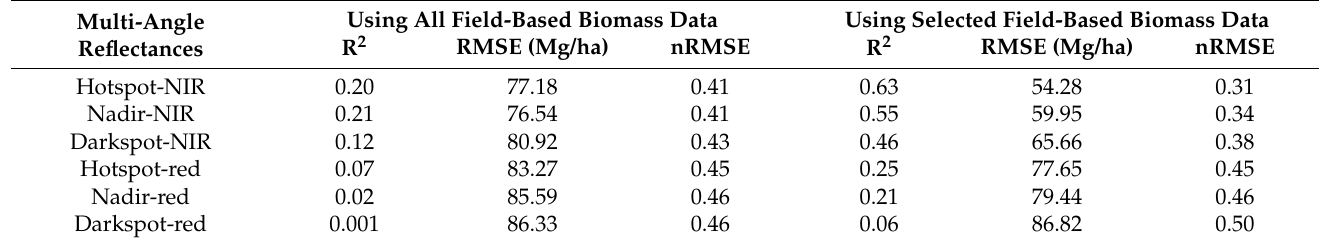
Table 3. Regression results for estimating forest AGB using MODIS typical-angle reflectances based on field-based forest biomass data.